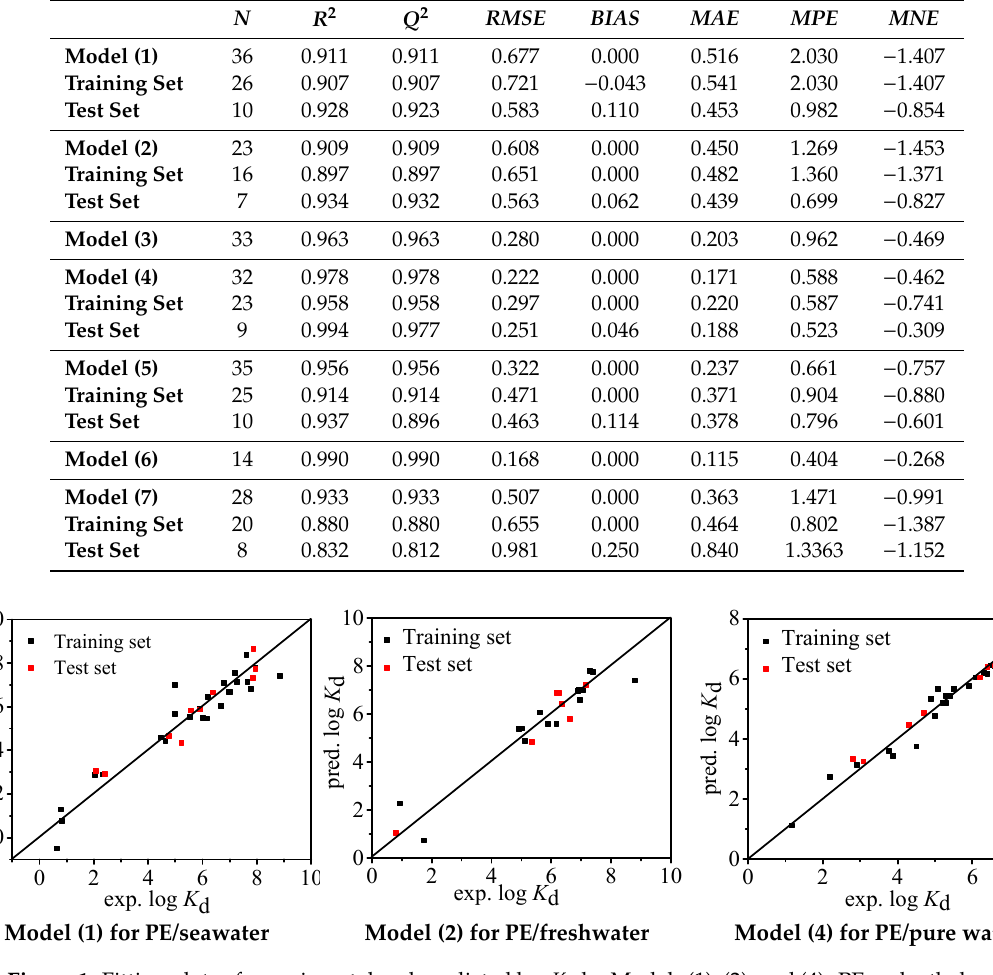
Table 1. Statistical parameters of the regression models and simulated external validation. N